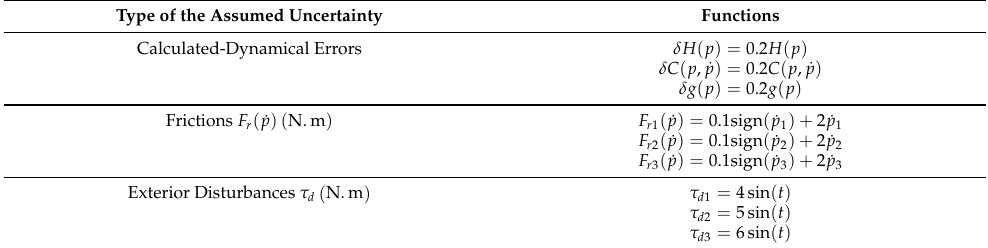
Table 3. Assumed Uncertain